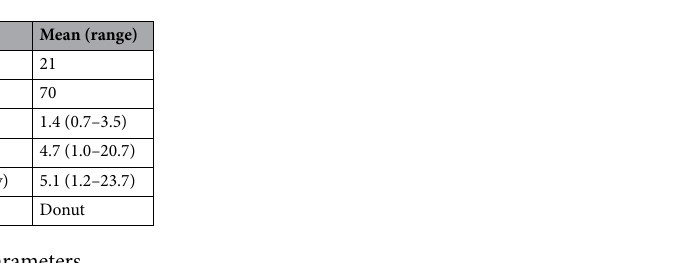
Table 2. Radiation treatment